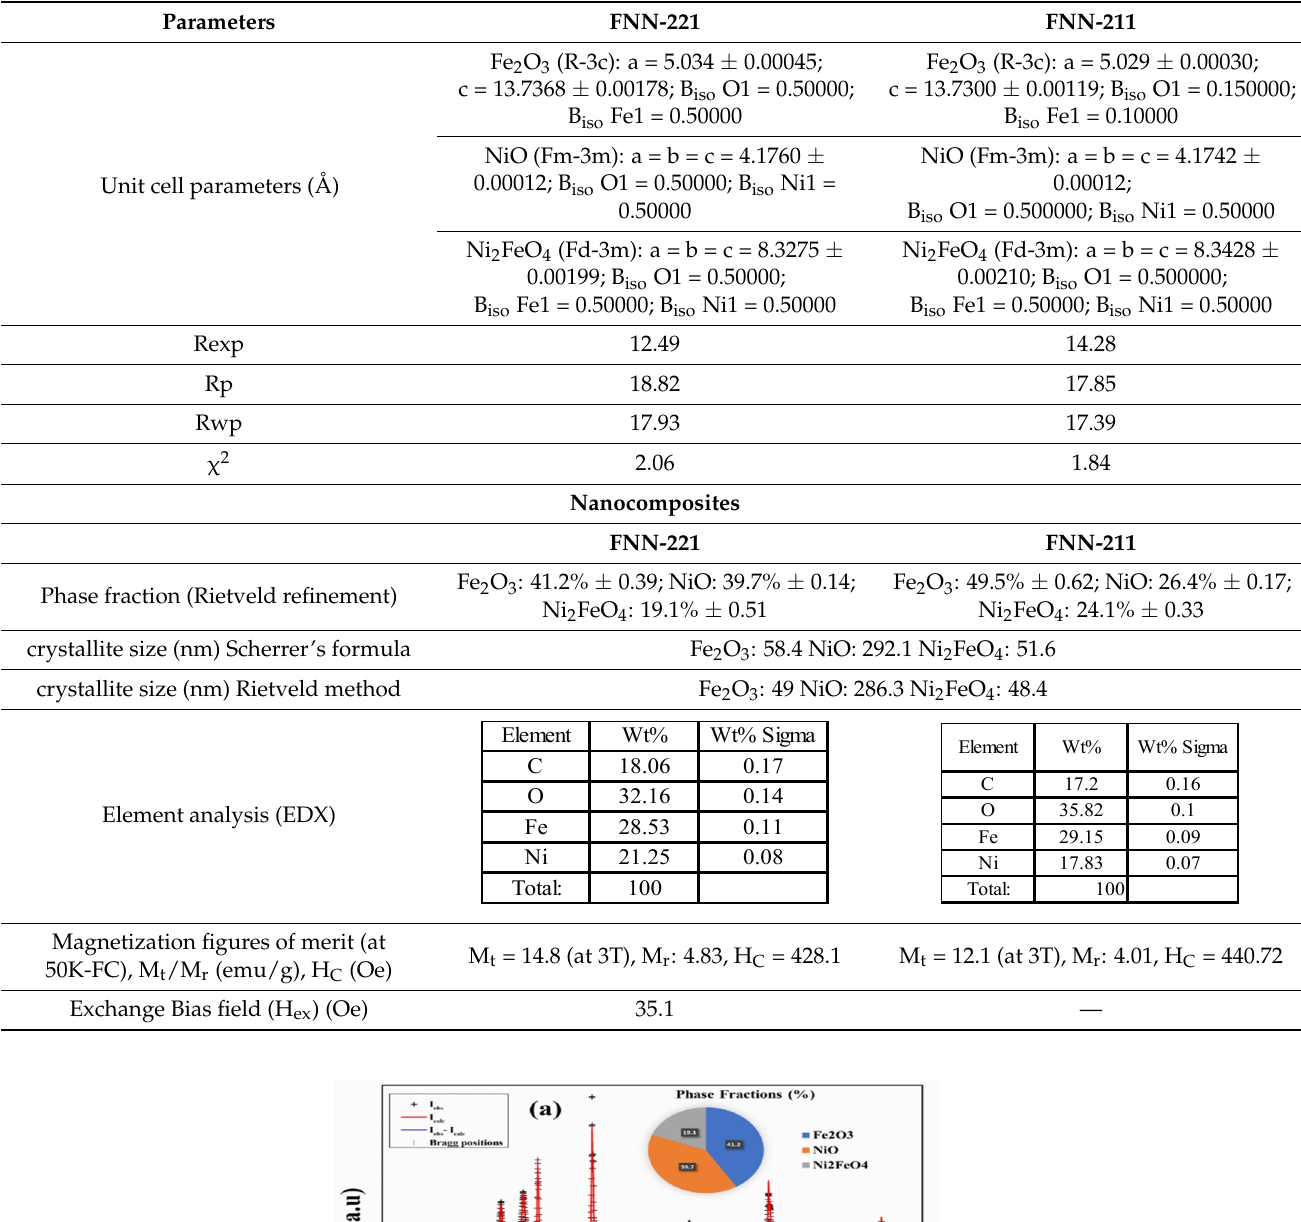
Table 2. The phase fraction (in molar) of components and concentration of each element present in the sample (obtained from XRD and EDX analysis, respectively); comparison of different figure of merits acquired from the magnetization measurements. For each component the thermal parameters were kept constant while performing the calculations.